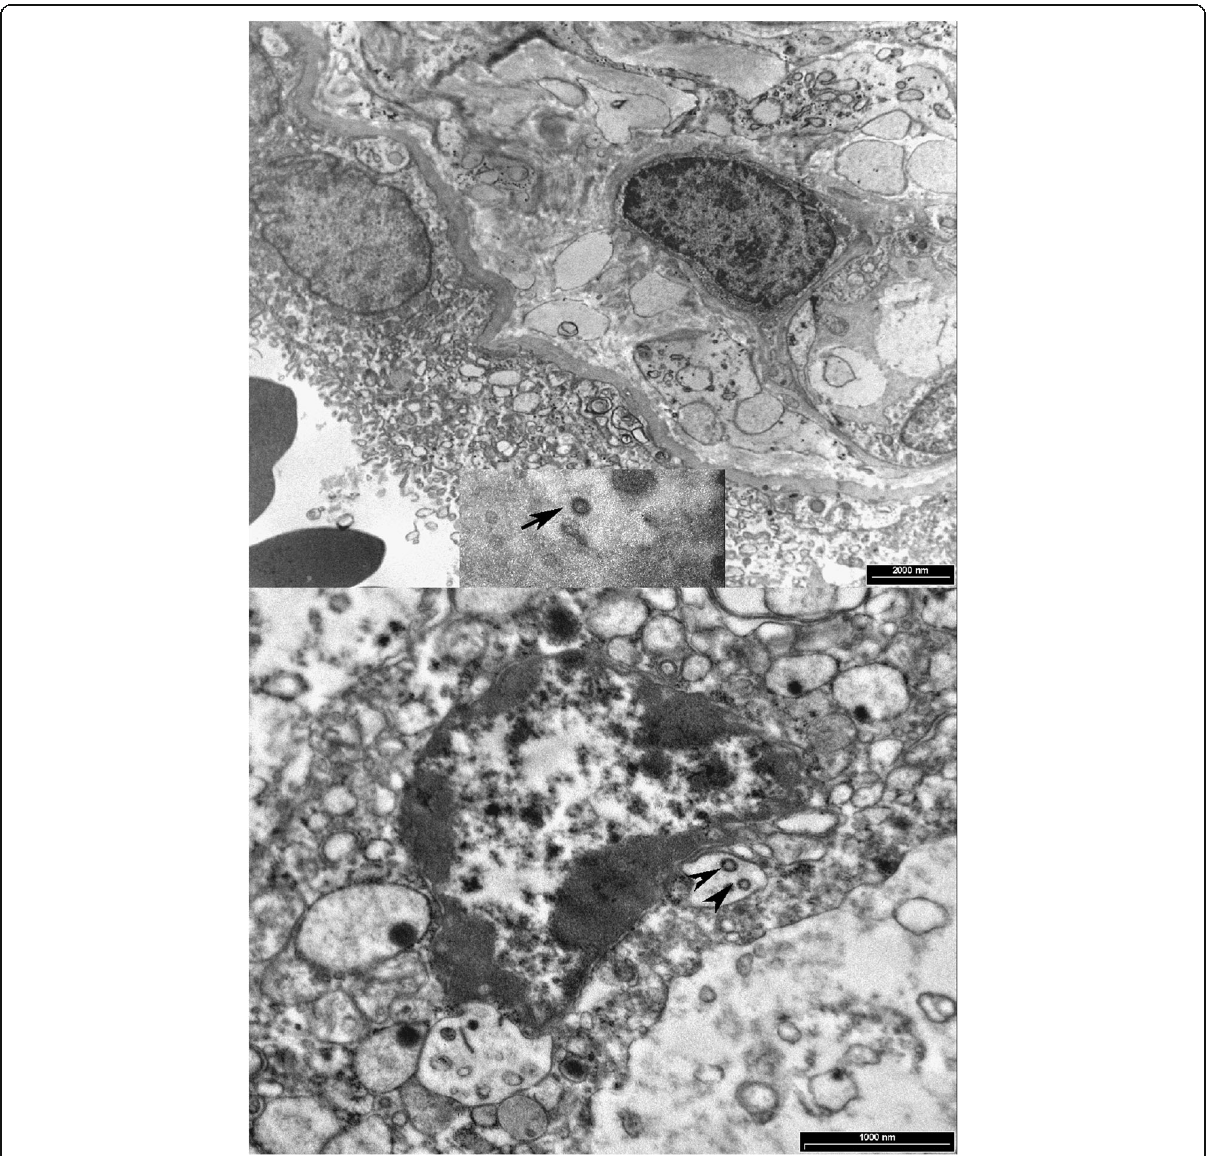
Fig. 7 Ultrathin sections showing spherical-like coronavirus particles free in the cytoplasm of syncytiotrophoblasts ( a : Case 3, Arrow: intracellular spherical-like coronavirus particle) or within a vesicle of syncytiotrophoblasts ( b : Case 5,